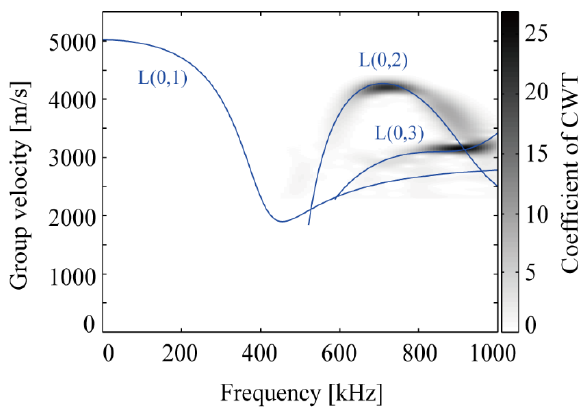
Figure 4. Group velocity dispersion curves of longitudinal modes for a 7 mm diameter galvanized steel wire.